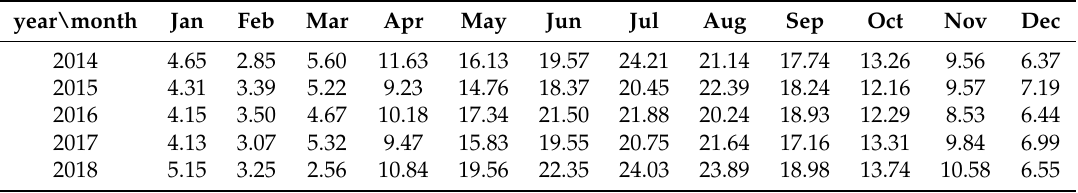
Figure A8. Monthly means of water temperature at sea surface for separated years. January to June. Table A3. Monthly maximums for surface temperature for the years 2014–2018.